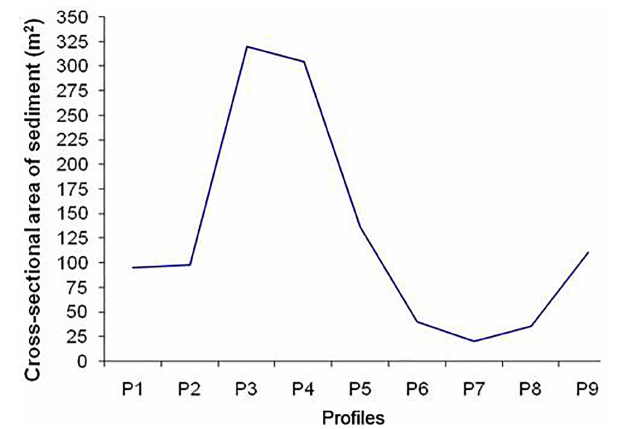
Figure 5. Cross-sectional areas of sediment at the measured profiles along the Ghézala river (in May 1993).